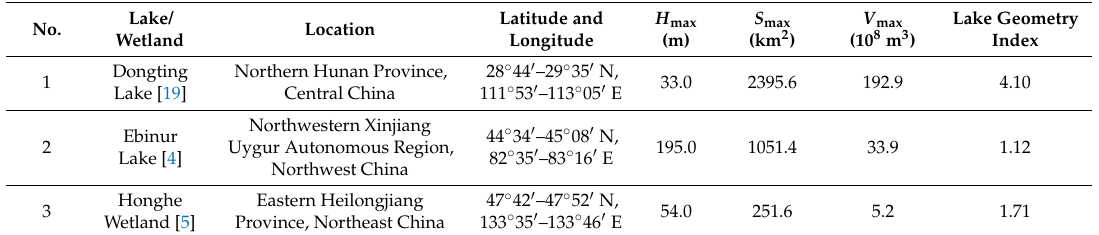
Table 1. Basic information about the study lakes and